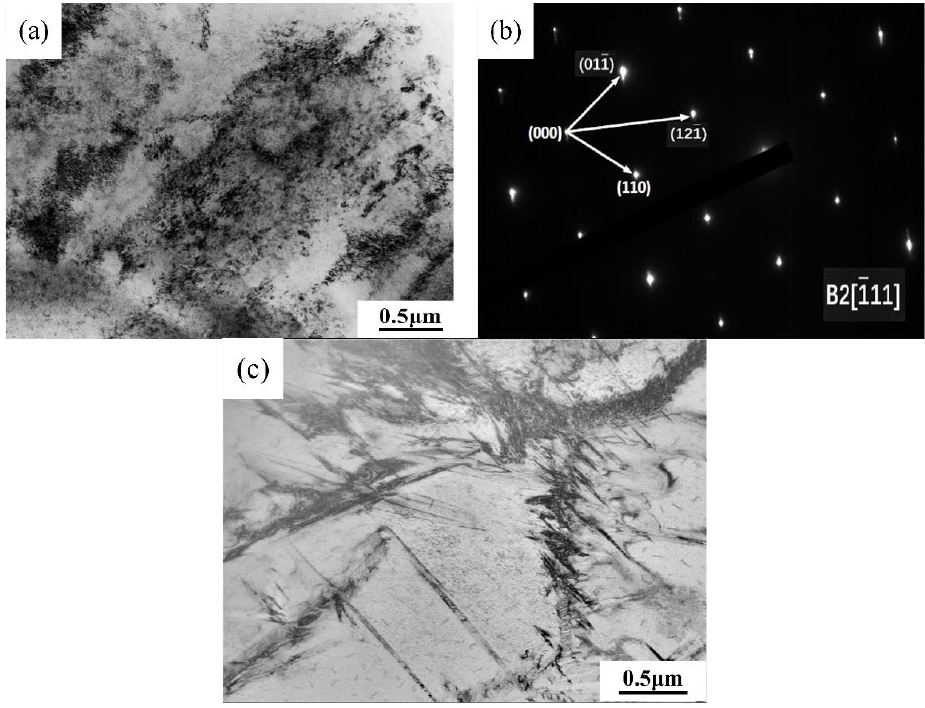
Figure 6. TEM results of weld zone without filler metal: ( a ) B2 phase, ( b ) selected area diffraction pattern, and ( c ) needle-like martensite. Table 3. The chemical composition of the weld zone and gas pore wall in the weld without filler metal.